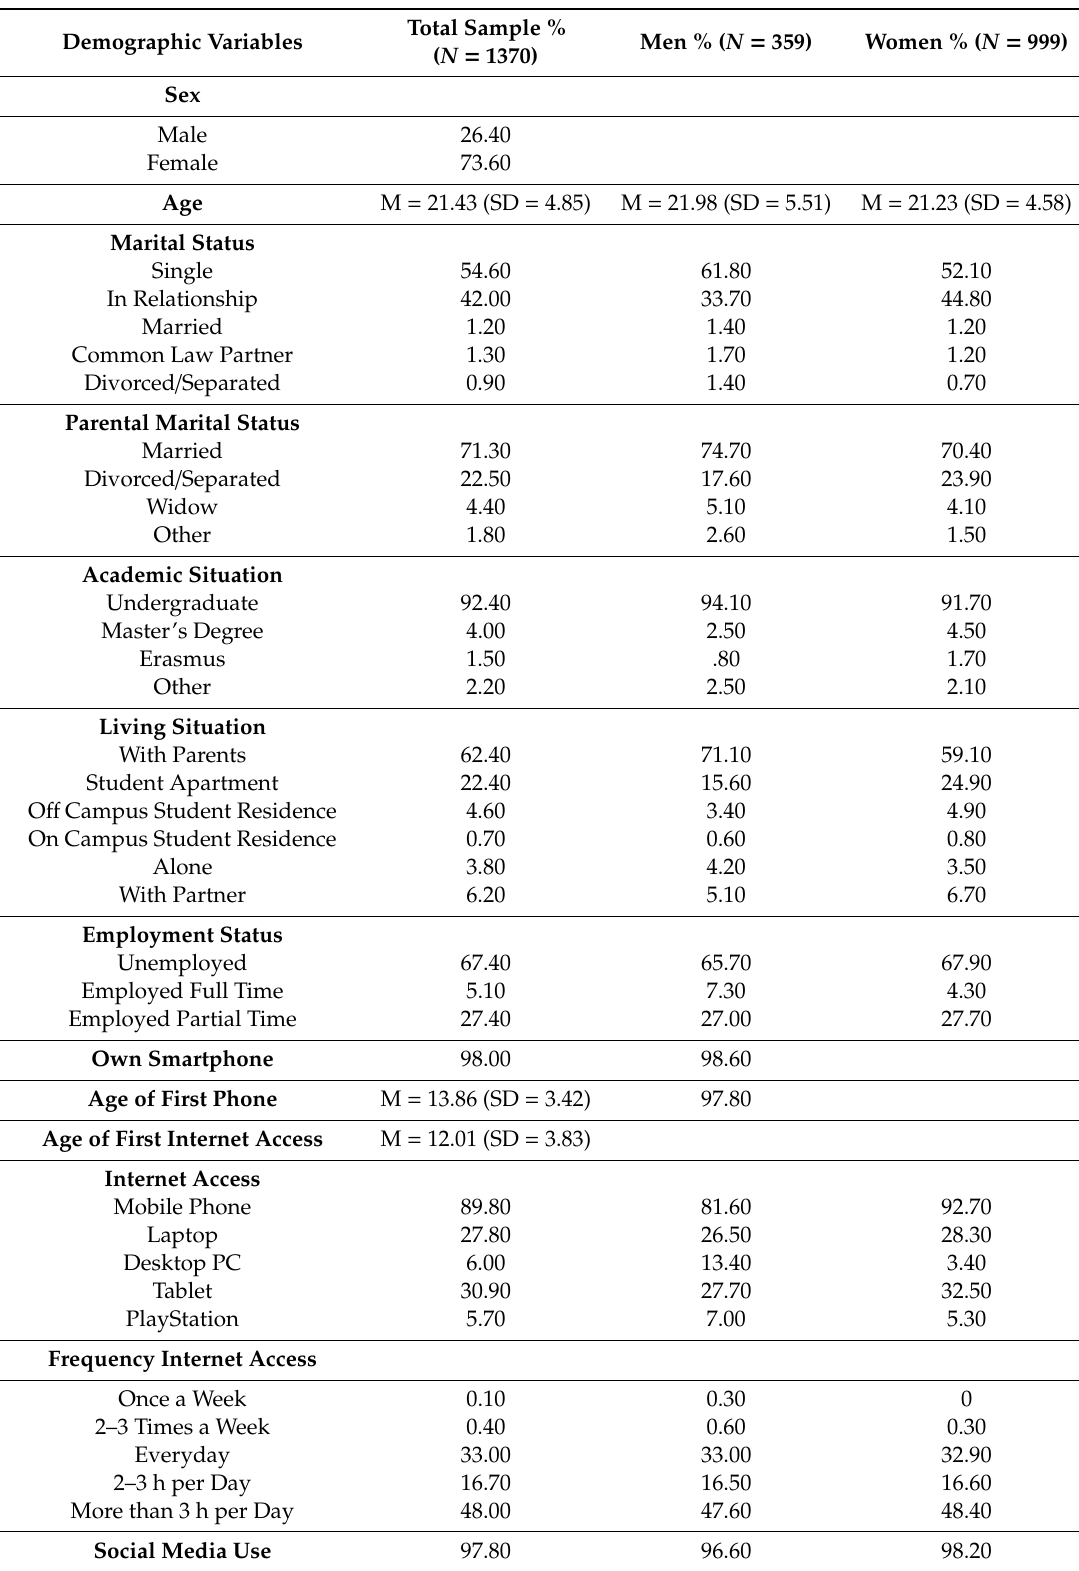
Table 1. Descriptive statistics of demographic and background